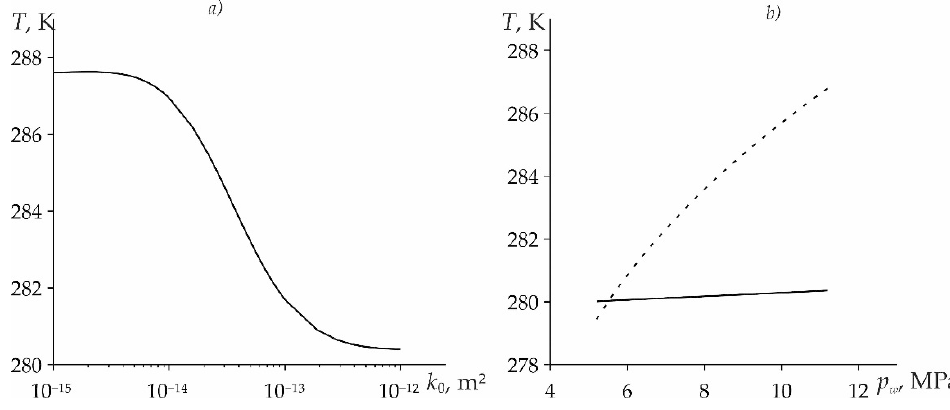
Figure 7. Dependence of the maximum temperature on the absolute reservoir permeability ( a ) and injection pressure ( b ). The dashed line is the equilibrium temperature.